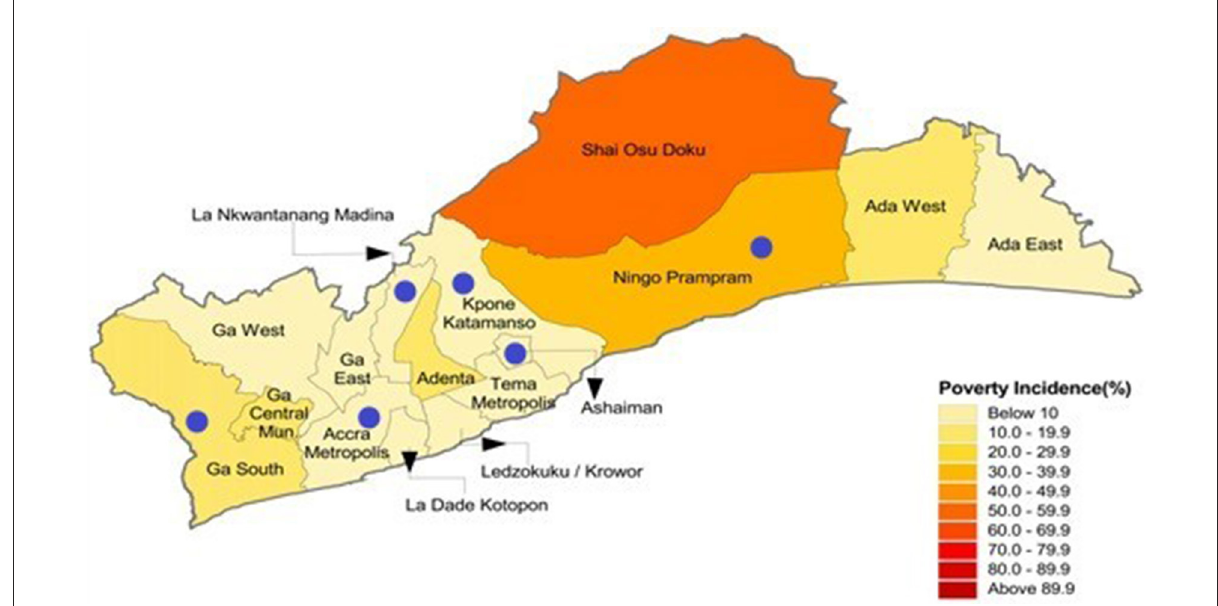
FIGURE1 Map of the Greater Accra region of Ghana showing the various districts and poverty